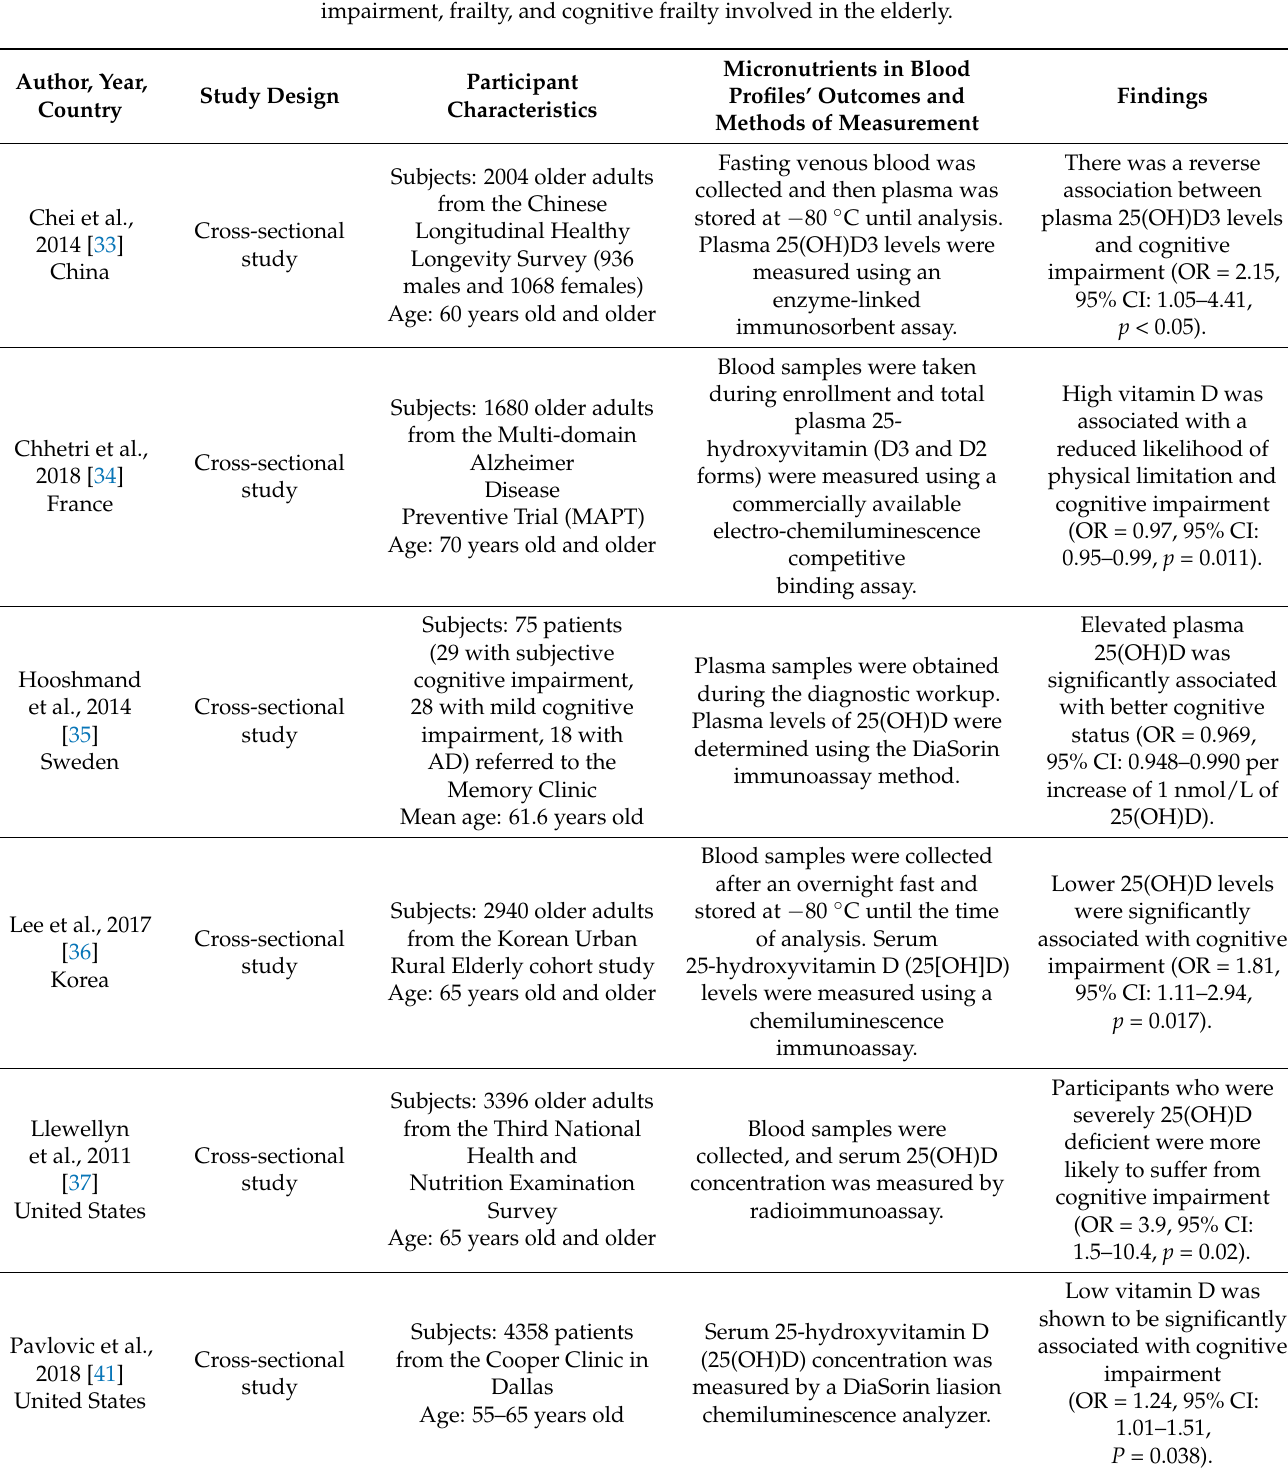
Table 3. Summary of studies evaluating the association between vitamin D with mild cognitive impairment, frailty, and cognitive frailty involved in the